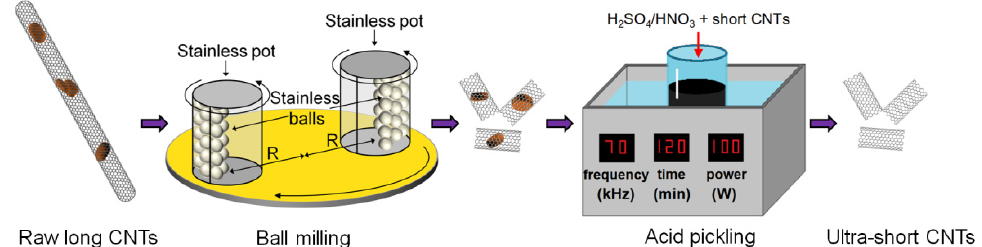
Figure 1. Schematic of the fabrication of ultra-short carbon nanotubes (CNTs) using ball milling and acid pickling methods.